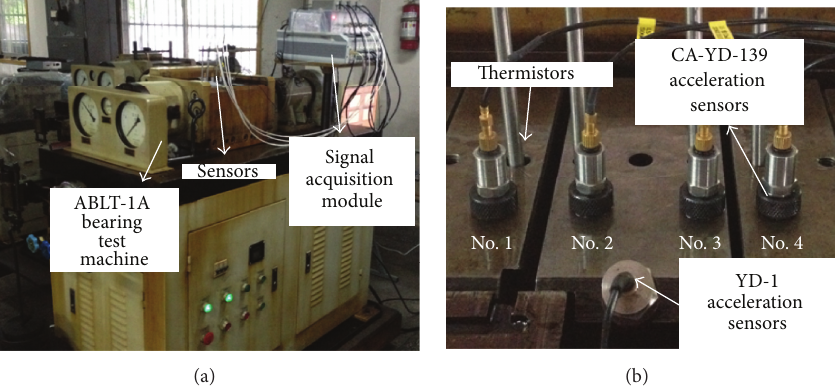
Figure 2: Bearing life experiment layout: (a) complete machine and (b) sensors.